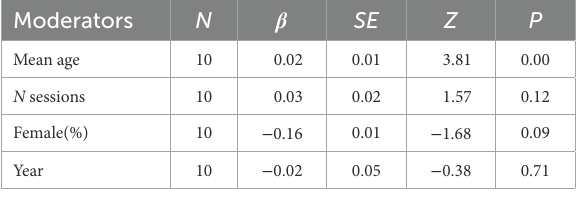
symptoms at post-test.